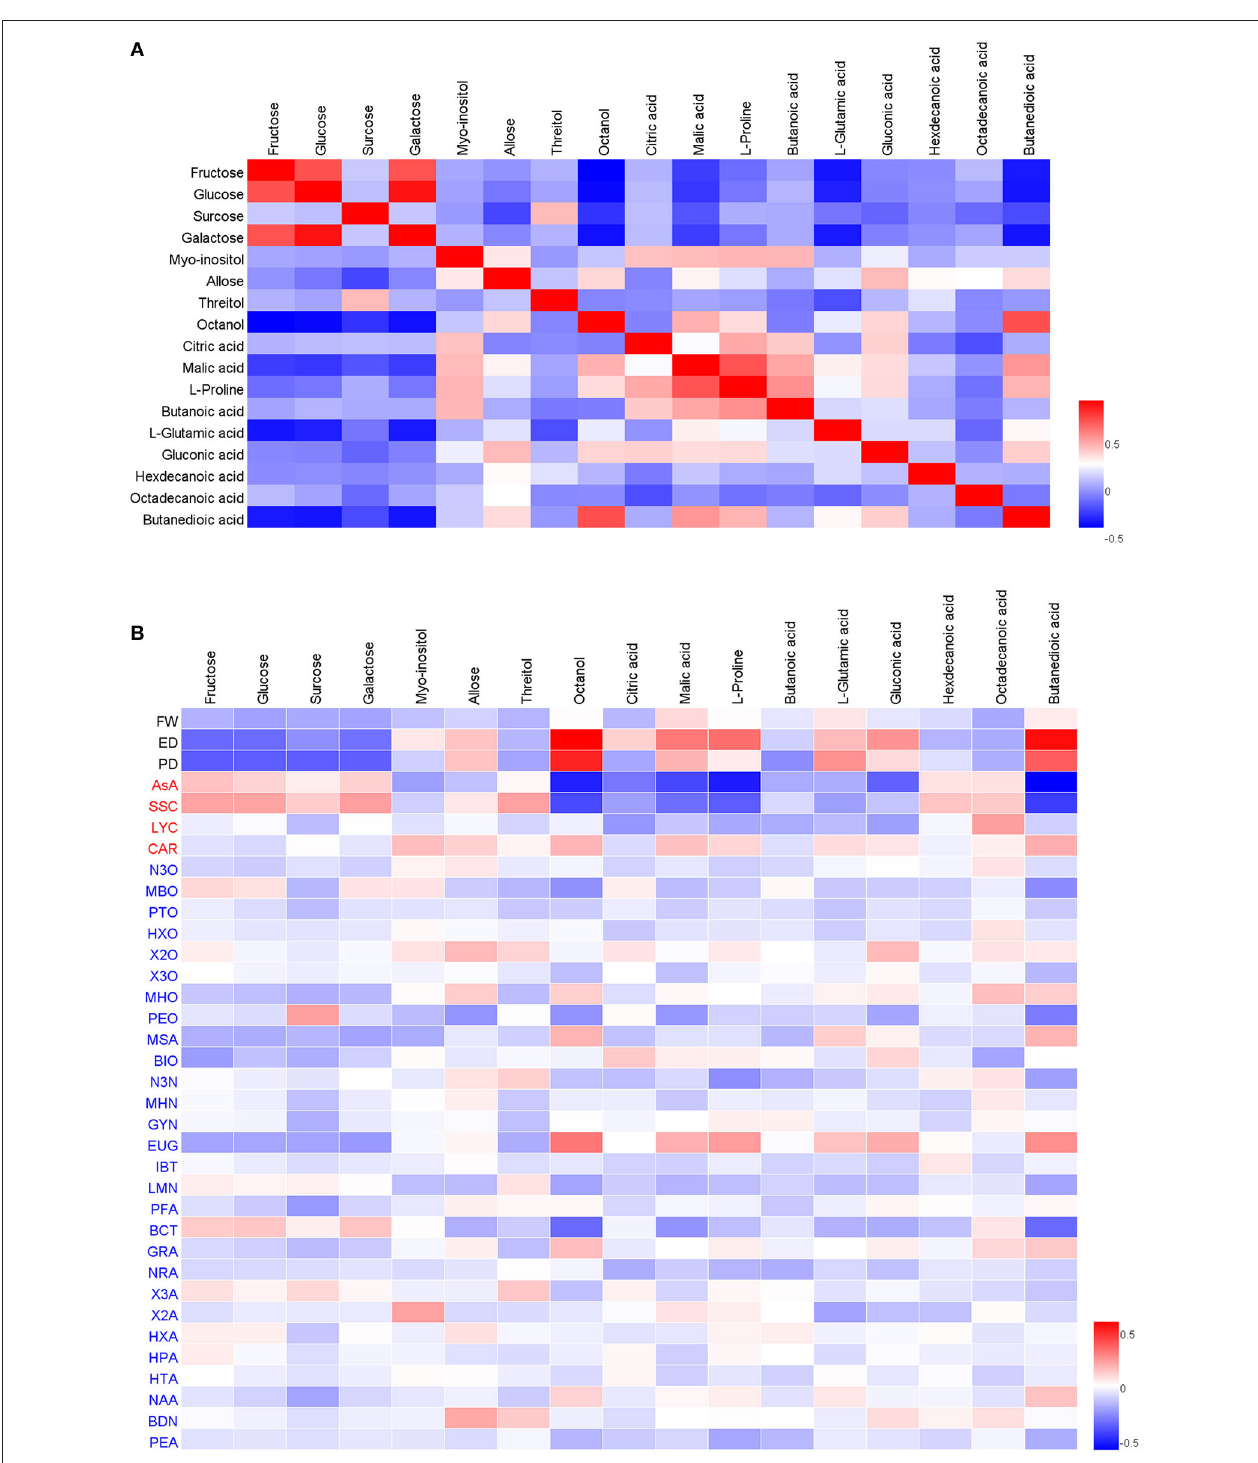
FIGURE 1 | The Pearson correlation analysis of the main sugars, organic acids, morphological, nutritional, and sensory traits. Panel (A) is the correlation between the main sugars and organics; Panel (B) is the correlation between the main sugars, organic acids, and morphological, nutritional and sensory traits. Positive correlations are indicated in red, while negative correlations are indicated in